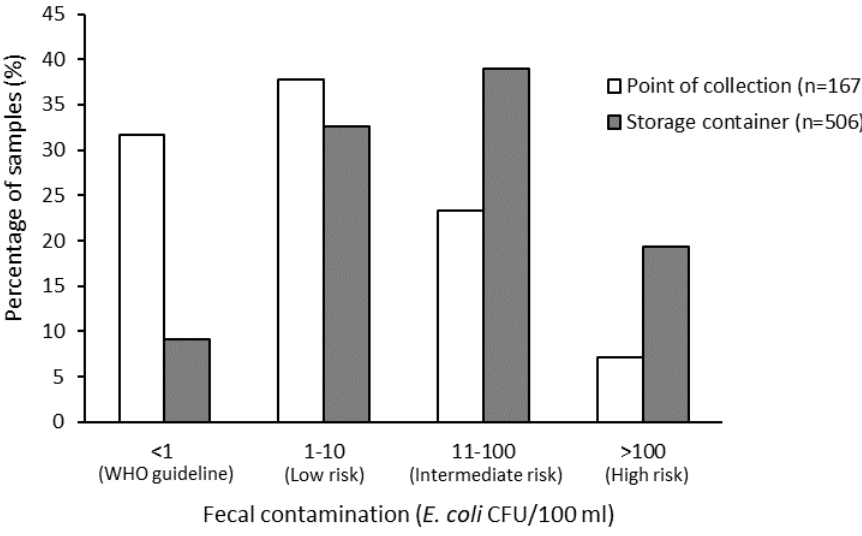
Figure 3. E. coli concentration at the point of collection (POC) and in households’ water storage container.